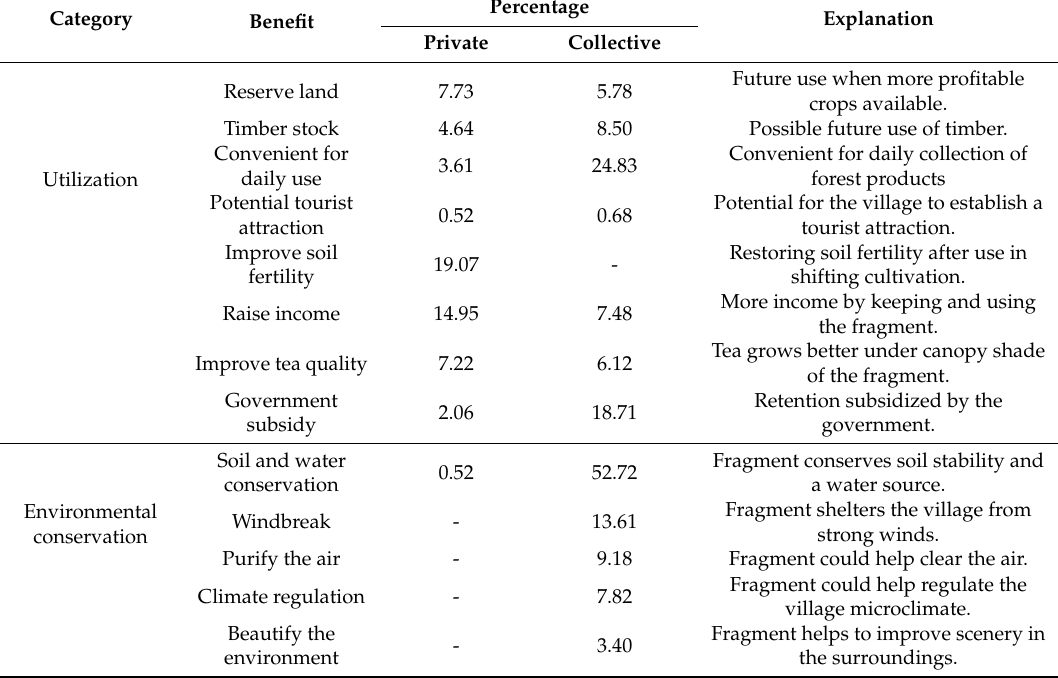
Table 3. Benefits of the existence of natural forest fragments. Percentages are the percentage of interviewees who gave this